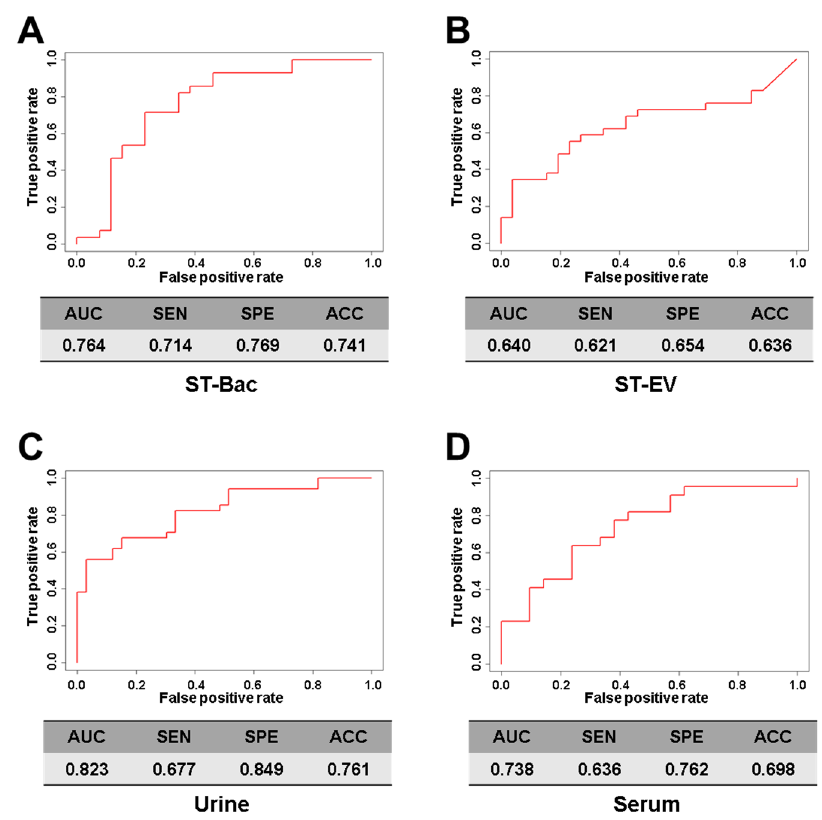
Figure 6. Comparison of gastric cancer diagnostic prediction models between healthy controls and gastric cancer patients in 4 sample types. ROC curves of gastric cancer diagnostic prediction models were developed through stepwise selection of significantly altered genera. Models were validated by performance evaluation in the test set by assessing the area under the curve (AUC), sensitivity, specificity, and accuracy. Performance indices of each model are demonstrated: ( A ) stool bacteria (ST-Bac) isolated from stool pellet, ( B ) stool-derived extracellular vesicle (ST-EV) isolated from stool supernatant, ( C ) urine, and ( D ) serum. SEN, sensitivity; SPE, specificity; ACC, accuracy. As a result, the model using the urine samples showed the highest AUC value of 0.823 (Figure 6C). Although the sensitivity was rather low (67.7%) in this model, the specificity (84.9%) and accuracy (76.1%) were high when compared to other models. The ST-Bac-based model showed an AUC score of 0.764, lower than the urine-based model, but their sensitivity (71.4%), specificity (76.9%), and accuracy (74.1%) were generally high (Figure 6A). The ST-EV-based model and serum-based model revealed lower AUC values and accuracies than the two models mentioned above (Figure